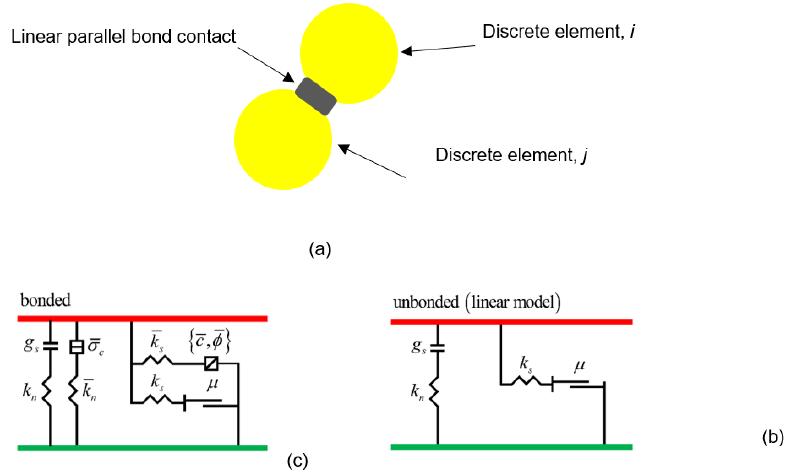
Figure 2. Illustration of linear parallel bond contacts in PFC [31]. ( a ) Parallel bond contact between two circular elements, ( b ) bonded interface law, ( c ) unbonded interface law.